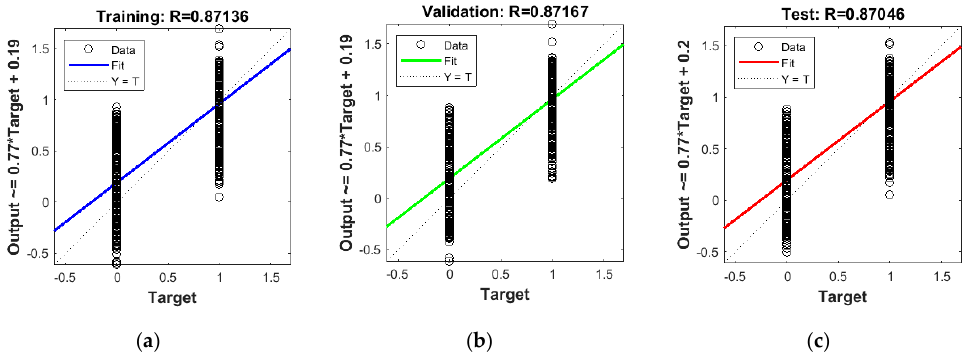
Figure 10. Regression statistics for ( a ) training set, ( b ) validation set and ( c ) testing set.